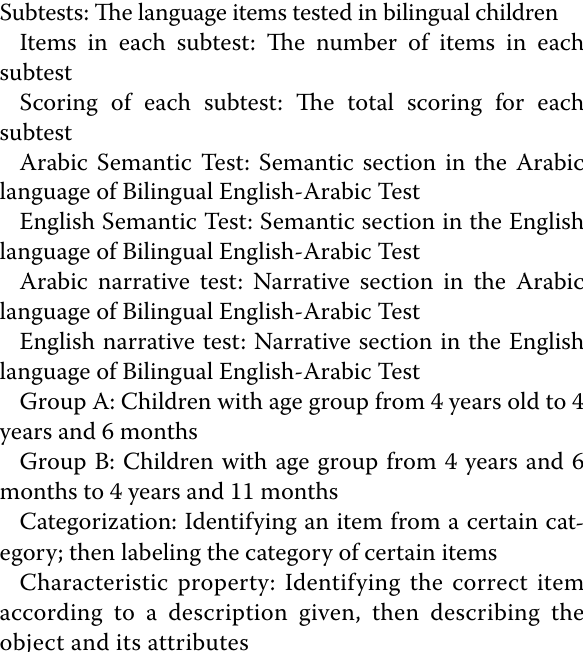
Subtests: The language items tested in bilingual